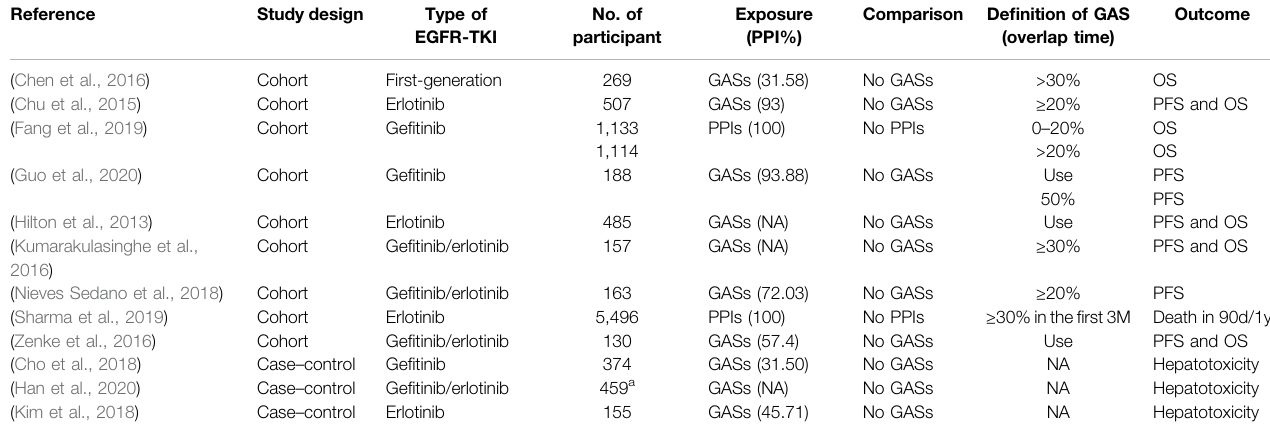
TABLE 1 | Main characteristics of the included